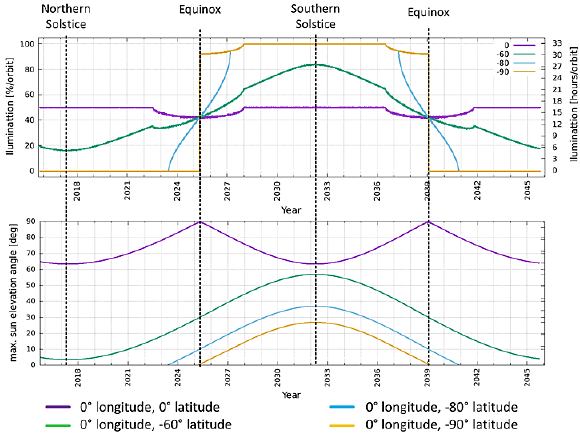
Figure 7: Illumination conditions on the prime meridian, but 4 different latitudes on the surface of Enceladus. The top diagram shows the illumination duration for each of these points in percentage per orbit and hours per orbit. The bottom diagram shows the corresponding maximum sun elevation angles for each